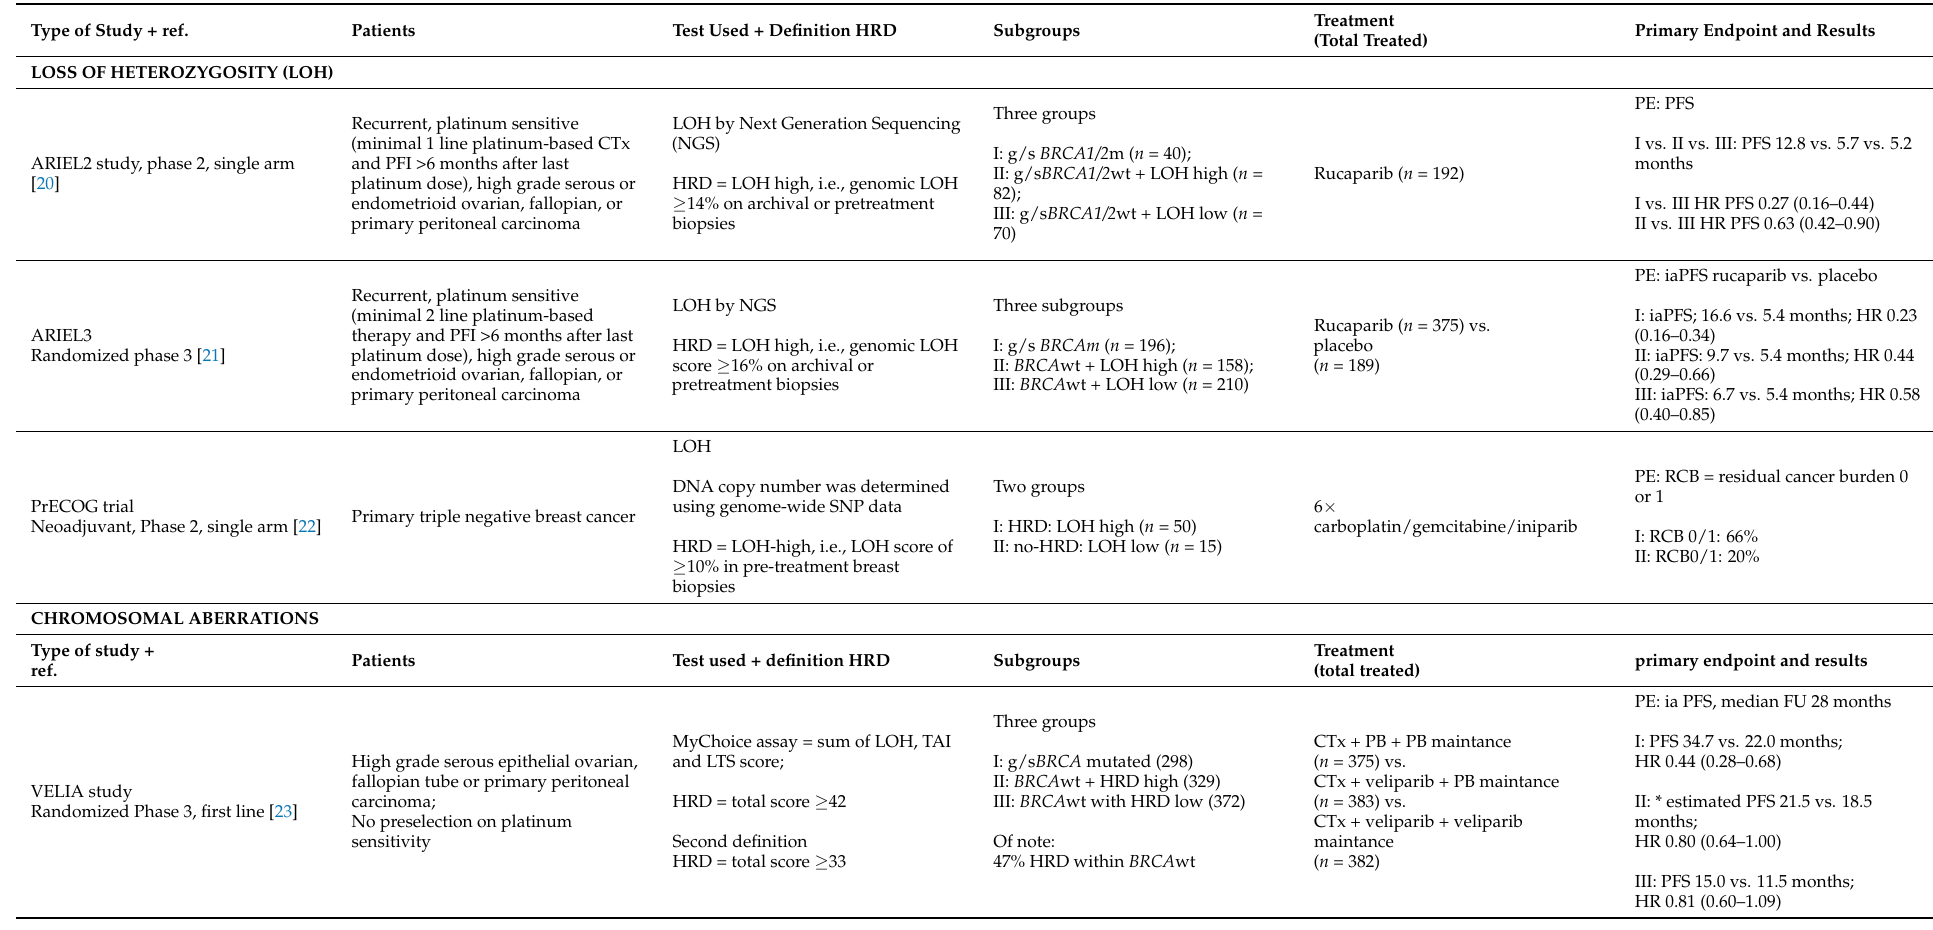
Table 2. Clinical studies investigating the predictive value of HRD measured by loss of heterozygosity (LOH) or chromosomal aberrations. Type of Study +